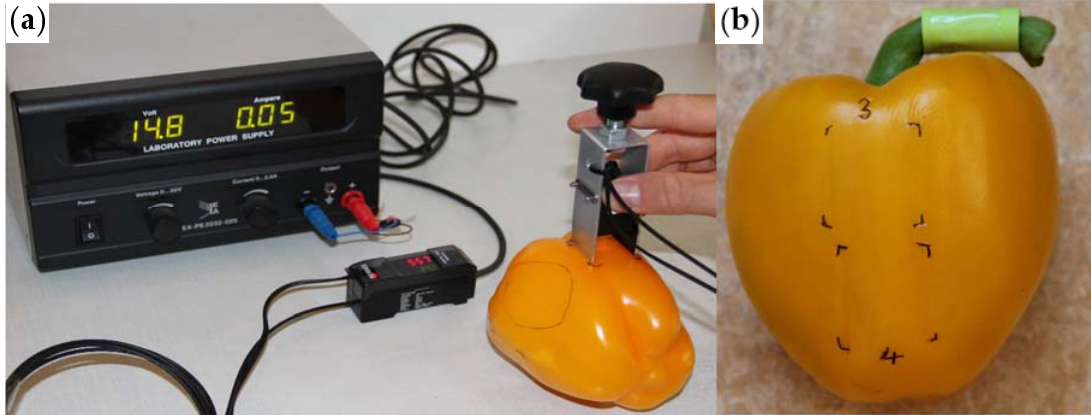
Figure 2. ( a ) Gloss measurements using our designed machined holder (left) and ( b ) marked spots/areas for repeated non ‐ invasive measurements at the same positions (right).